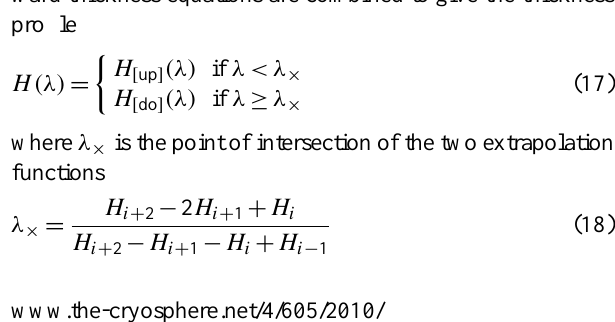
respectively. Assuming that H [ up ] and H [ do ] intersect in the grid cell containing the grounding line, the landward and